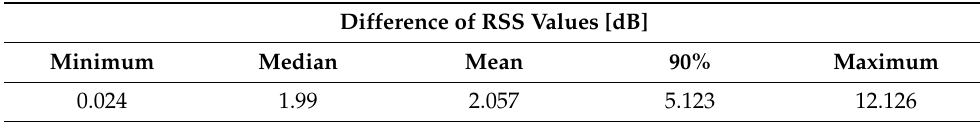
Table 2. Difference between static and dynamic RSS